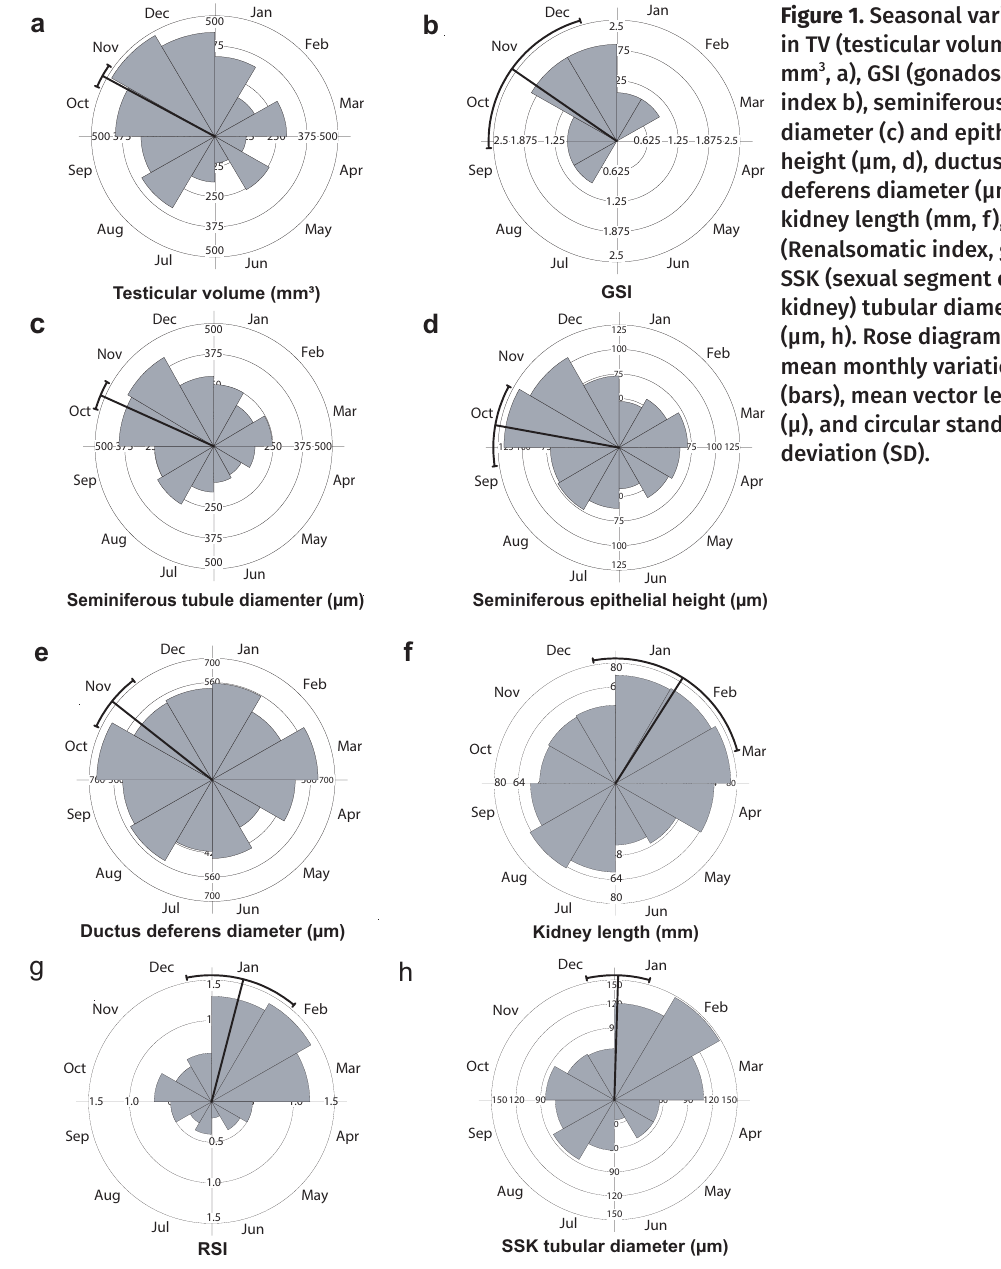
Figure 1. Seasonal